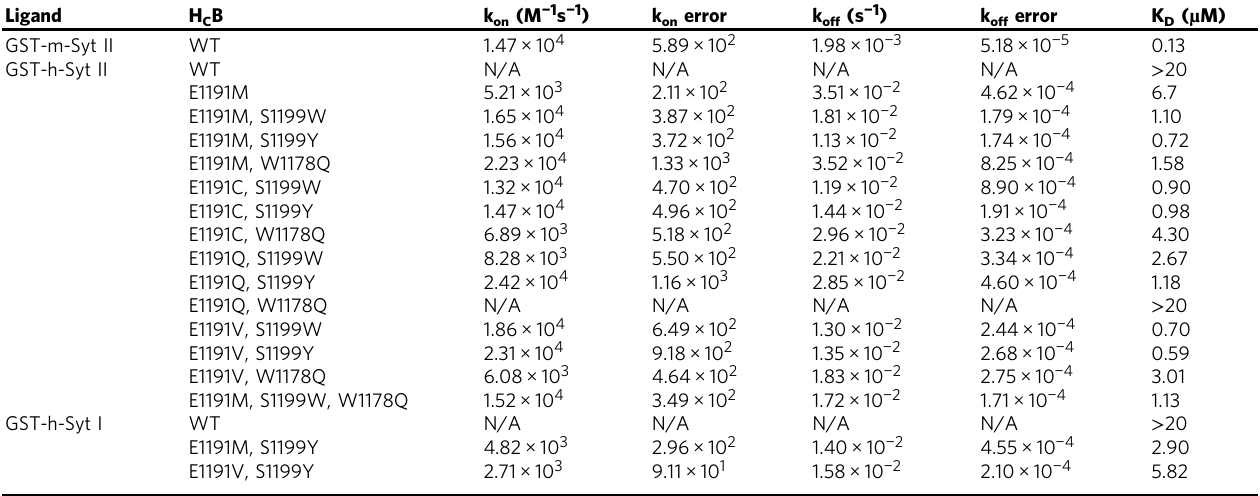
Table 1 Interactions between GST-Syt II/Syt I and H C B variants measured by BLI